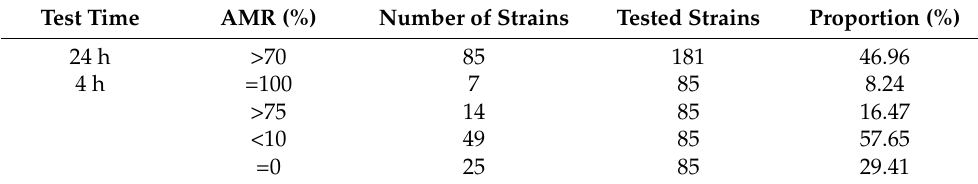
Table 1. Toxicity on brine shrimp of the static cultivation supernatants of 181 marine-derived fungal strains at 24 and 4 h. The 85 strains showed here at 4 h were those with more than 70% of adjusted mortality rate (AMR) at 24 h.